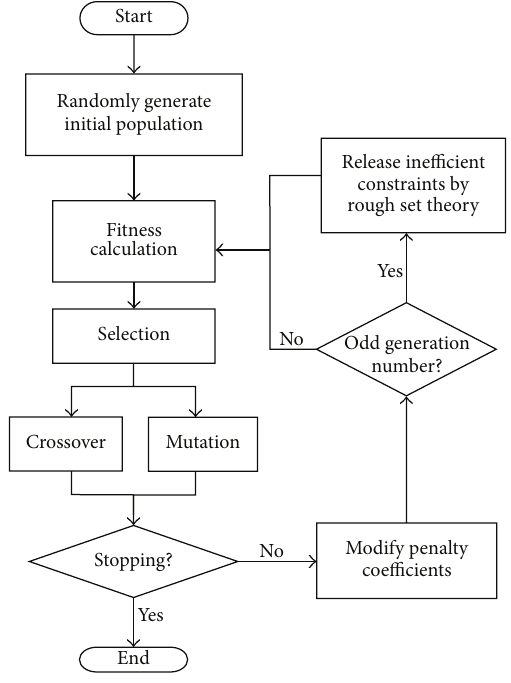
Figure 2: Flow chart of the